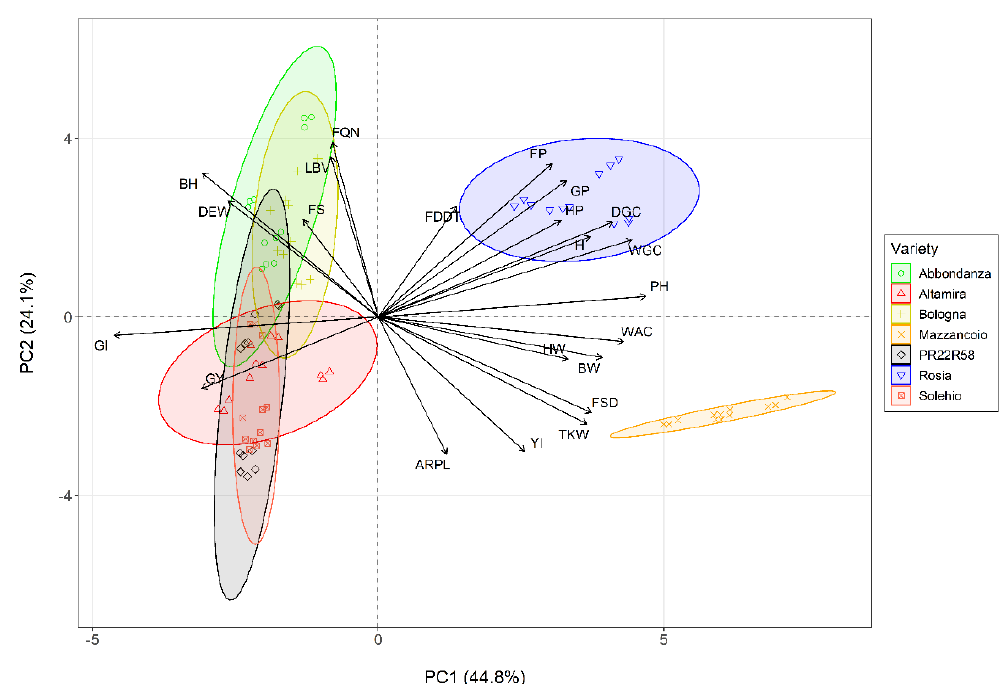
Figure 3. Biplot of principal component scores and loading vectors. Observations are shown as points with different shapes as described by the legend. Variables are shown as vectors. The first component (PC1) accounts for 44.8% of the variance, while the second component (PC2) for the 24.1%. Point concentration ellipses are drawn assuming a multivariate t-distribution with a confidence interval of 95%. GY, grain yield; HP, heading period; PH, plant height; HW, hectolitre weight; TKW, thousand kernel weight; H, hardness; GP, grain protein; YI, yellow index; FP, flour protein; WGC, wet gluten content; DGC, dry gluten content; GI, gluten index; DEW, deformation energy W; ARPL, alveograph ratio P/L; FDDT, farinograph dough development time; FS, farinograph stability, FSD, farinograph softening degree; WAC, water absorption capacity; FQN, farinograph quality number; LBV, loaf bread volume; BH, bread height; BW, bread weight.